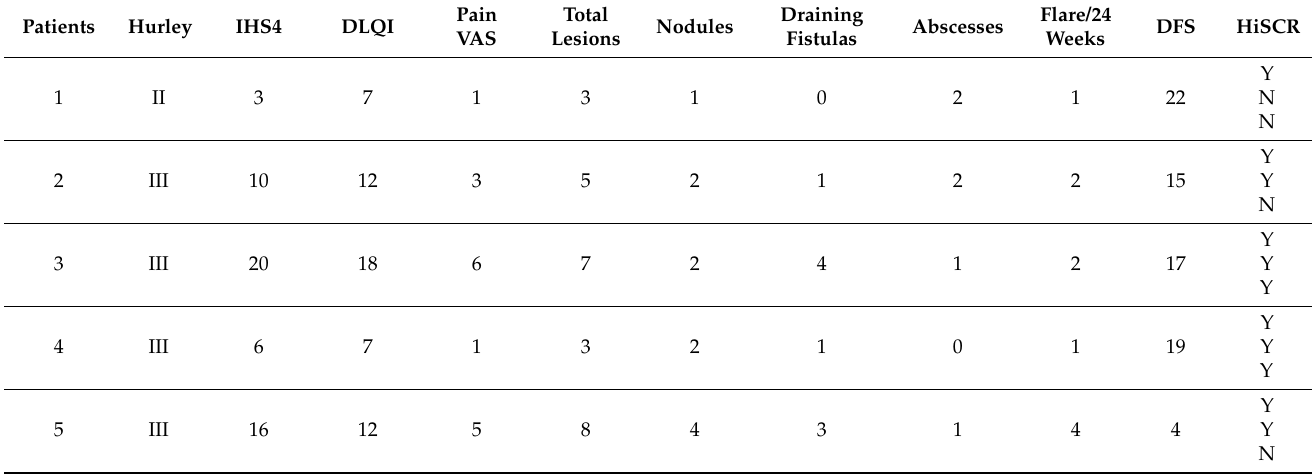
Table 4. Clinical assessment at week 24